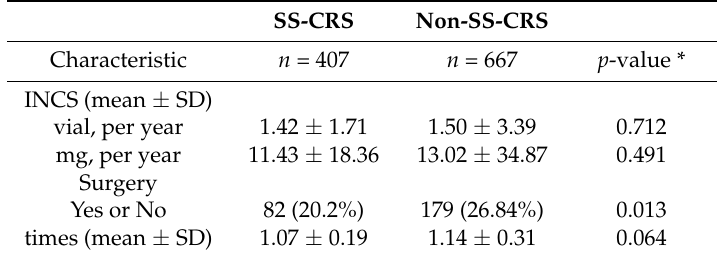
Table 3. Analysis of Medical and Surgical Therapies for CRS in SS and Non-SS. SS-CRS Non-SS-CRS Characteristic n = 407 n = 667 p -value * INCS (mean ± SD) vial, per year 1.42 ± 1.71 1.50 ± 3.39 0.712 mg, per year 11.43 ± 18.36 13.02 ± 34.87 0.491 Surgery Yes or No 82 (20.2%) 179 (26.84%) 0.013 times (mean ± SD) 1.07 ± 0.19 1.14 ± 0.31